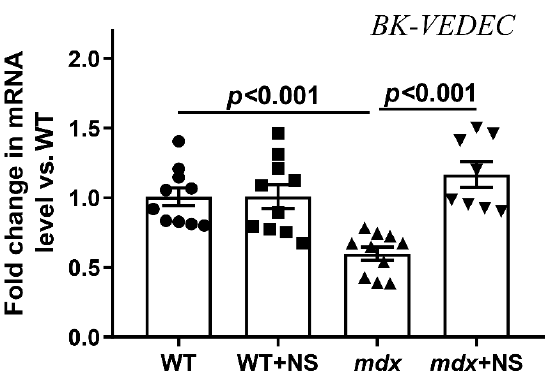
Figure 2. Relative level of BK-VEDEC mRNA (encoding mitoBK Ca channel) in the skeletal muscle of experimental animals. The data are presented as m ± SEM.